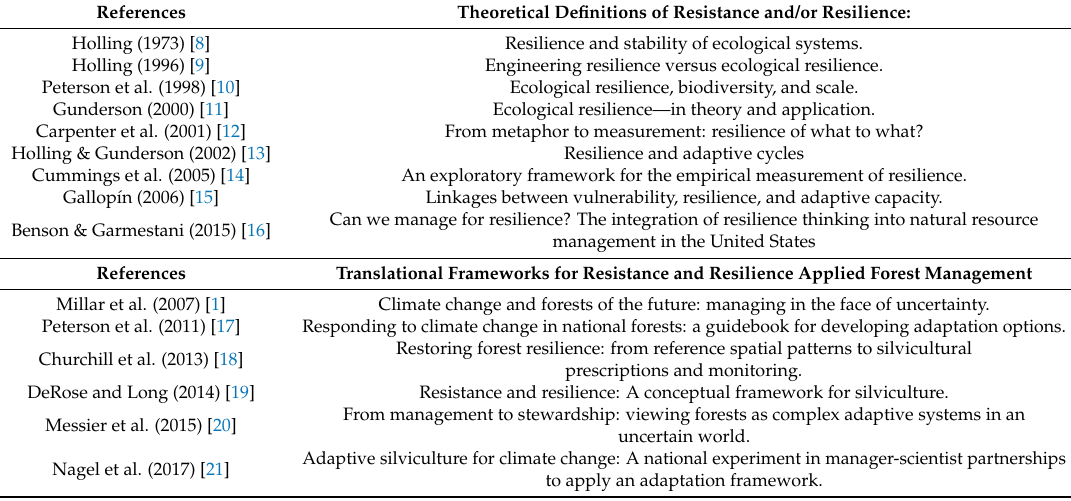
Figure 1. Number of publications by year since 1997 for the queries ‘forest AND resistance AND resilience’ and ‘forest AND resistance AND resilience AND regeneration’ using Scholar Plot R (https://csullender.com/scholar/) accessed on 23 February 2018. Table 1. A small subset of the resistance and resilience literature includes multiple definitions of the terms. The theoretical papers serve as an important base of basic understanding but are often too abstract to translate in applied management. There has been an increasing effort to provide frameworks for managers in developing resistance and/or resilience forest ecosystems (see References for full citations).